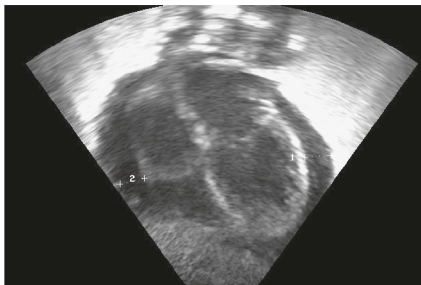
Figure 2: Echocardiography showing pericardial effusion. Di- mensions: 1 � 0.43cm; 2 � 0.41cm.